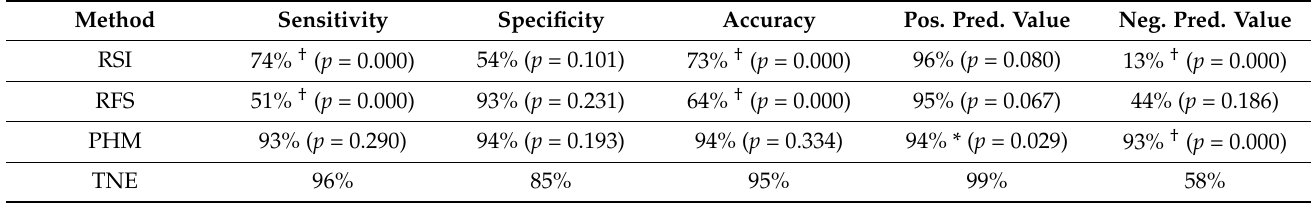
Table 4. Detection of laryngopharyngeal reflux ( n =